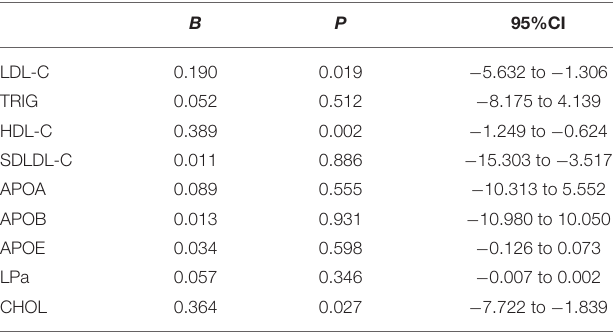
TABLE 4 | Multiple linear regressions for associations between lipid levels in patients with